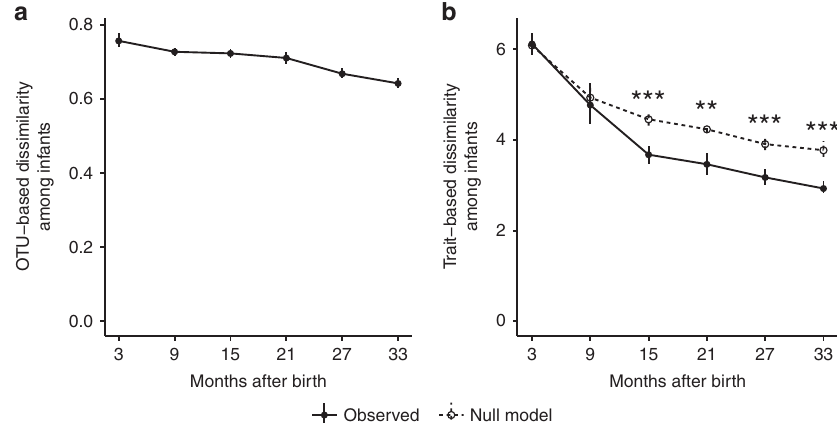
Fig. 5 Infants ’ microbiomes converge compositionally over time. Filled circles show mean compositional dissimilarities of gut microbiomes across infants within each 6-month periods. Mean dissimilarities were calculated by fi rst taking the mean dissimilarity of all sample pairs, except those from the same infant, in each of the fi rst 36 months of development (for these means, N ranges from 88 to 3410), and then taking their means within each 6-month period; hence, for each circle, N equals 6. OTU-based dissimilarity was calculated using Bray – Curtis dissimilarity. Trait-based dissimilarity was calculated using multidimensional Euclidean distance after scaling the distributions of values for each trait to ensure equal contribution. a OTU-based dissimilarity among infants decreased slightly over time, indicating a modest convergence in taxonomic composition. b Trait-based dissimilarity among infants fell quickly over the fi rst 18 months and then remained relatively static thereafter, indicating rapid convergence in trait-based composition during early succession. The magnitude of trait-based compositional convergence across infants was signi fi cantly greater than predicted by a null model assuming trait- agnostic turnover. Vertical lines show 95% con fi dence intervals. Asterisks denote signi fi cance between observed and null model predictions based on Welch t tests (* p <0.05; ** p <0.01; *** p